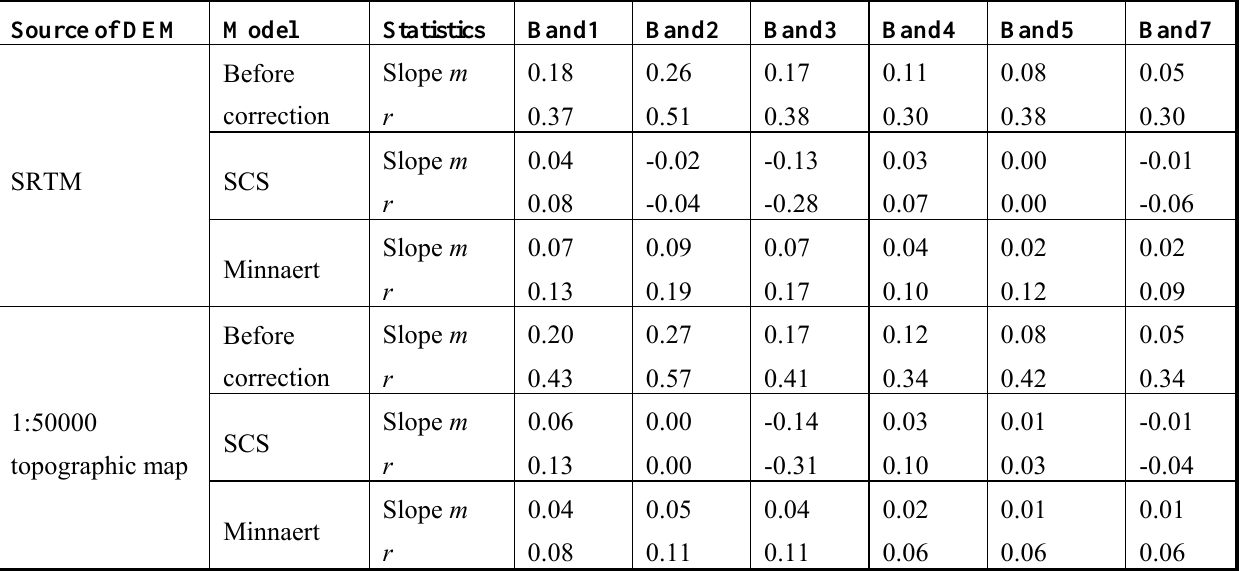
Table 3. Slope m and correlation coefficient r of regression model between ETM+ band 1- 5, 7 reflectance and cos i